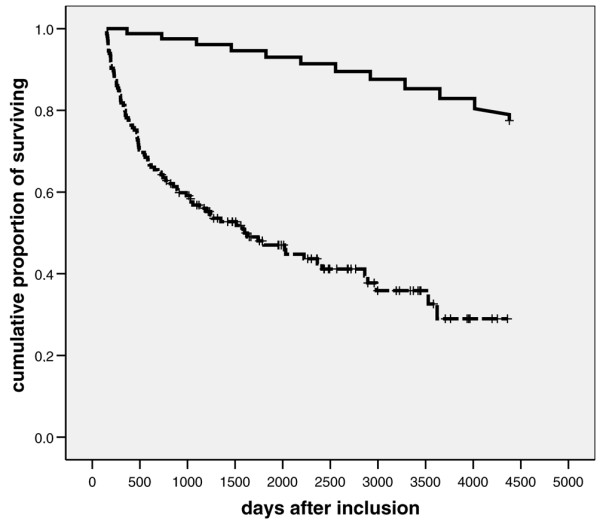
Twelve-year survival: chronically critically ill patients who have already survived 150 days versus general population. Presented are Kaplan-Meier plots showing 12-year survival rates (after inclusion) in patients surviving more than 150 days (dashed line) and in the German general population (continuous line; reference age 61 years; data from Statistisches Bundesamt Wiesbaden, Germany [30]).